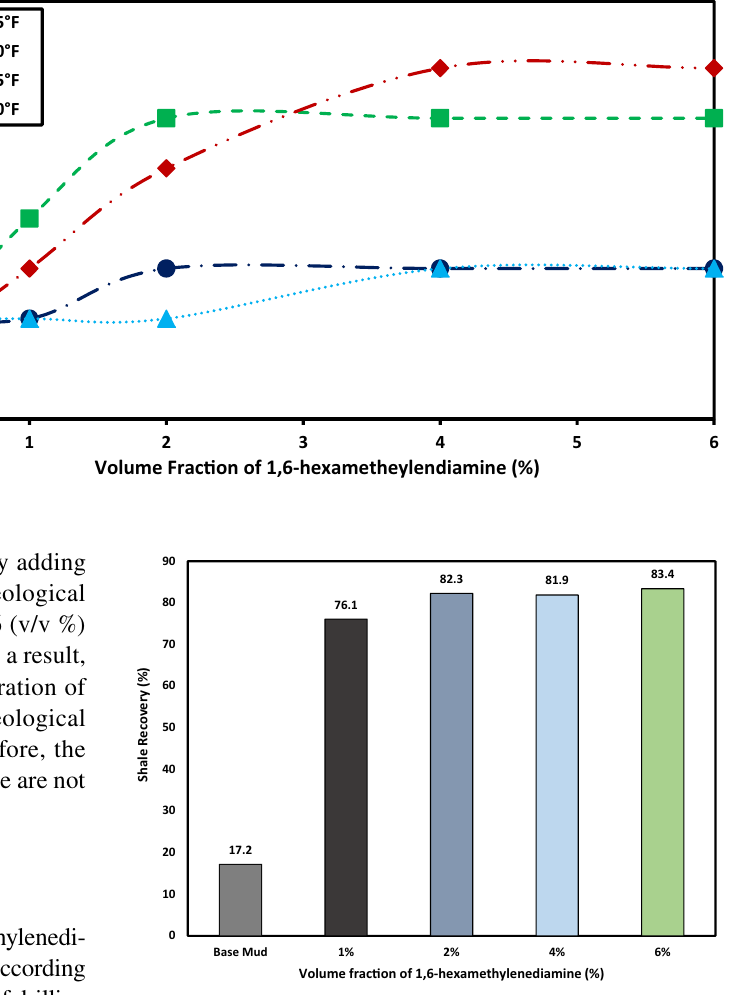
Fig. 13 Shale cutting recoveries of various amounts of